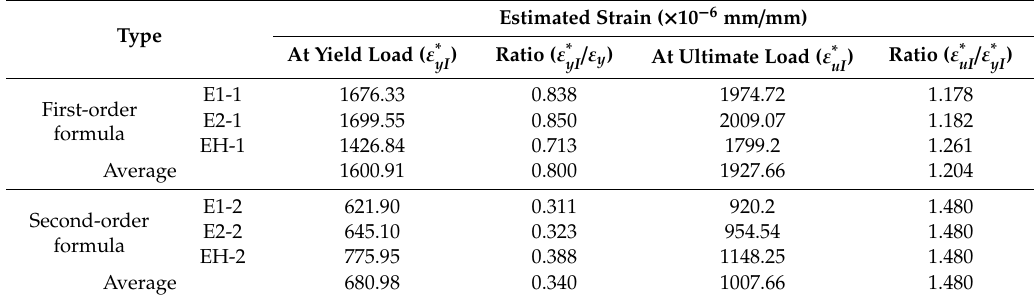
Table 5. Estimated strains of the integral specimen at the yield and ultimate loads.